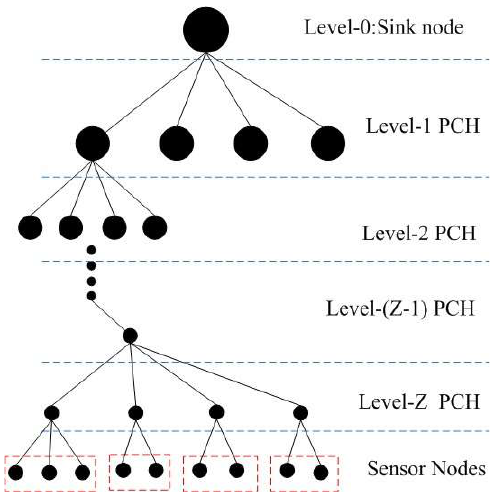
Figure 4. Topology structure of the network.